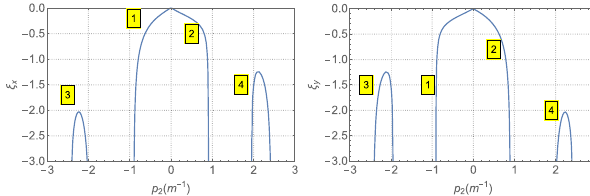
FIG. 4. Horizontal and vertical chromaticity vs second quadru- pole strength.